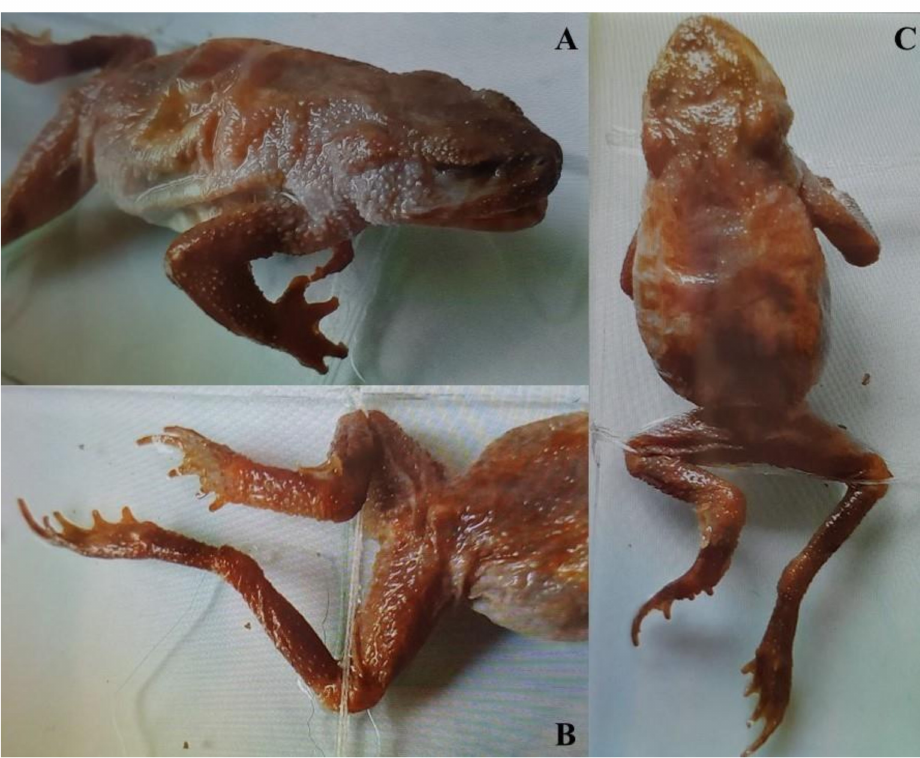
Figure 2. Pictures of the holotype of Bufo sambangensis presented by [9]. Note the morphological similarities with B. stejnegeri : ( A ) detailed pictures of the head; ( B ) detailed picture of the hind limbs; ( C ) dorsal picture. Pictures taken by Mr. Tu Yong Nam from Institute of Zoology of the State Academy of Science in the Democratic People’s Republic of